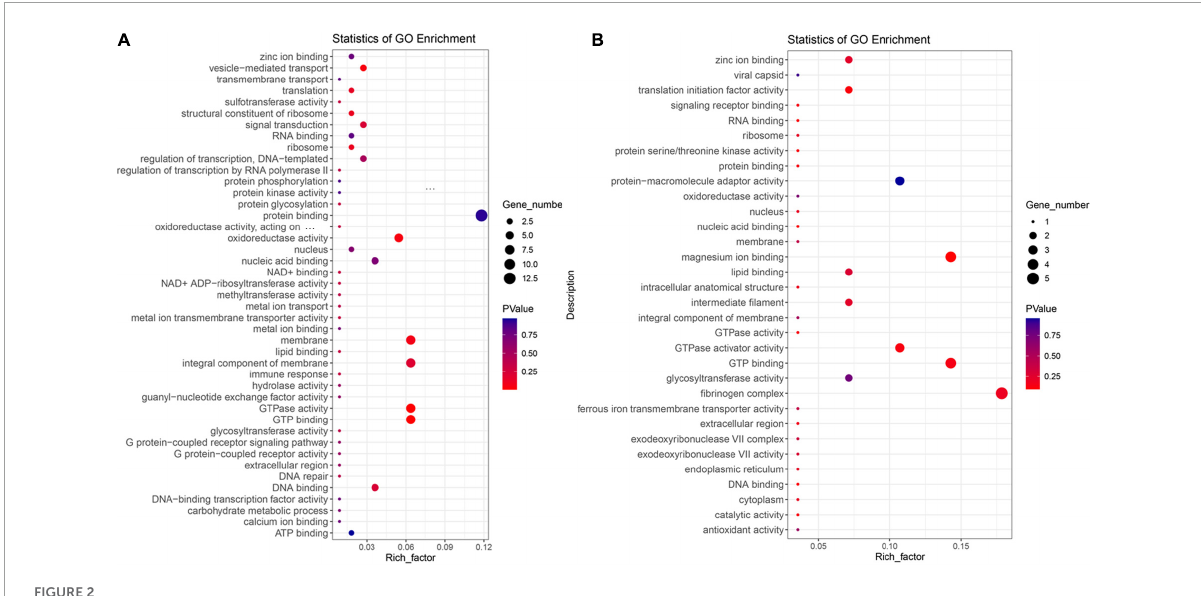
FIGURE2 GO enrichment analysis for positive selection genes. (A) GO enrichment analysis for positive selection genes of Vulpes ferrilata. (B) GO enrichment analysis for positive selection genes of Vulpes vulpes montana.